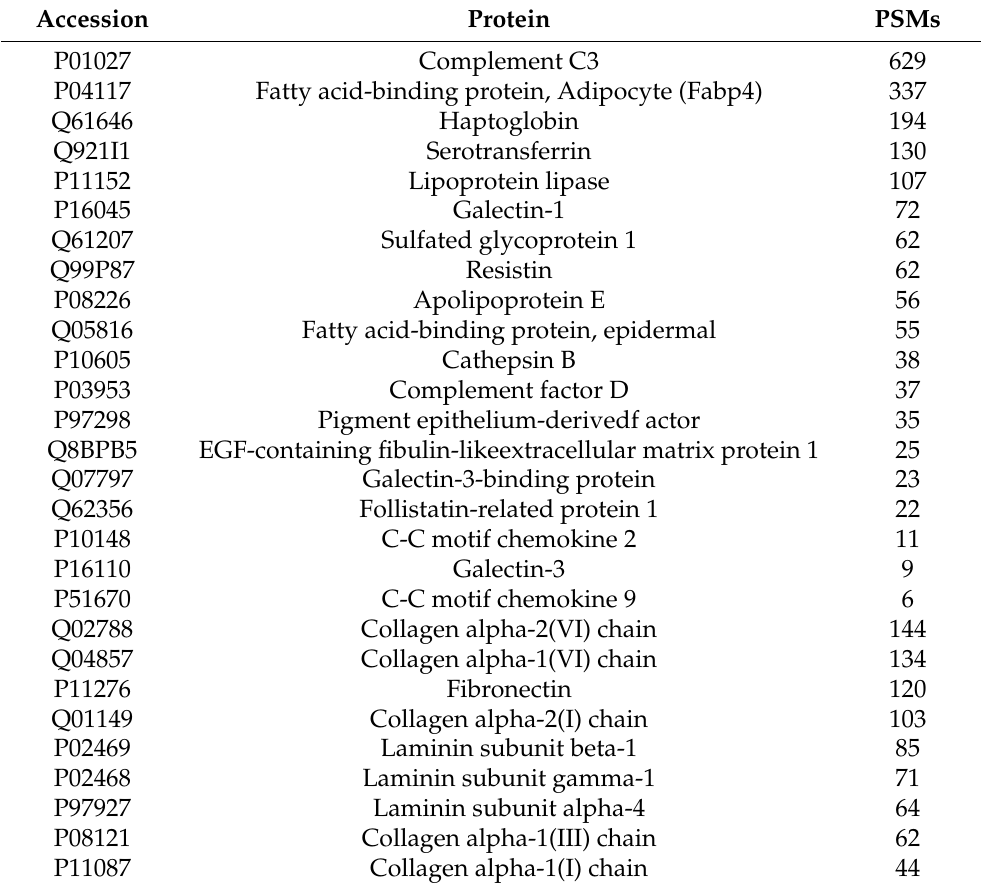
Table 1. List of identified humoral factors secreted from mature HB2 brown